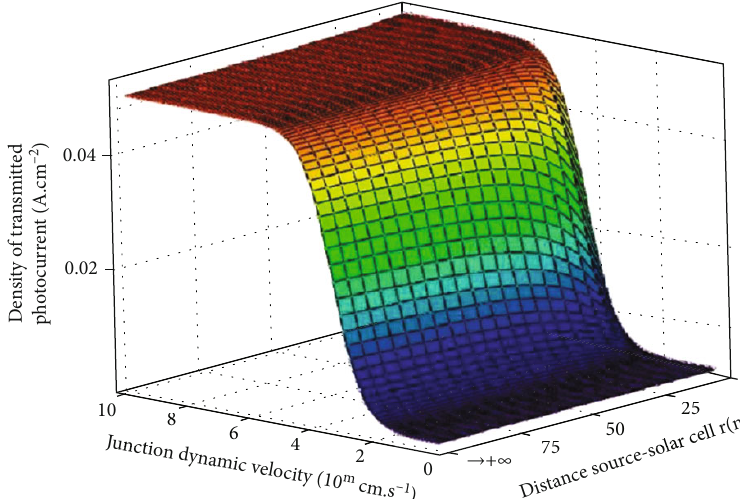
= 0 : 015cm, D = 26 cm 2 · s − 1 , μ n n n